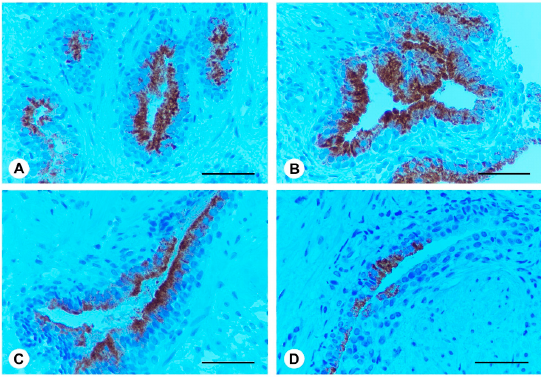
Figure 3. Prostate specific antigen (PSA) immunohistochemistry in the prostate from BPH patients at time 0; from BPH patients at 3 months; from Ser-Se-Ly treated BPH patients at time 0; and from Ser-Se-Ly treated BPH patients at 3 months. ( A , C ) In BPH patients at time 0 and in BPH patients treated with Ser-Se-Ly at time 0, uniform PSA immunoexpression is present in the apical portion of the epithelial cells cytoplasm. Basal and stromal cells are negative; ( B ) Similar high immunoexpression is evident in BPH patients after 3 months; ( D ) After 3 months of Ser-Se-Ly administration, PSA immunoexpression is focal in the pseudostratified epithelium, while basal cells are unreactive. (Scale bar: 50 µm).